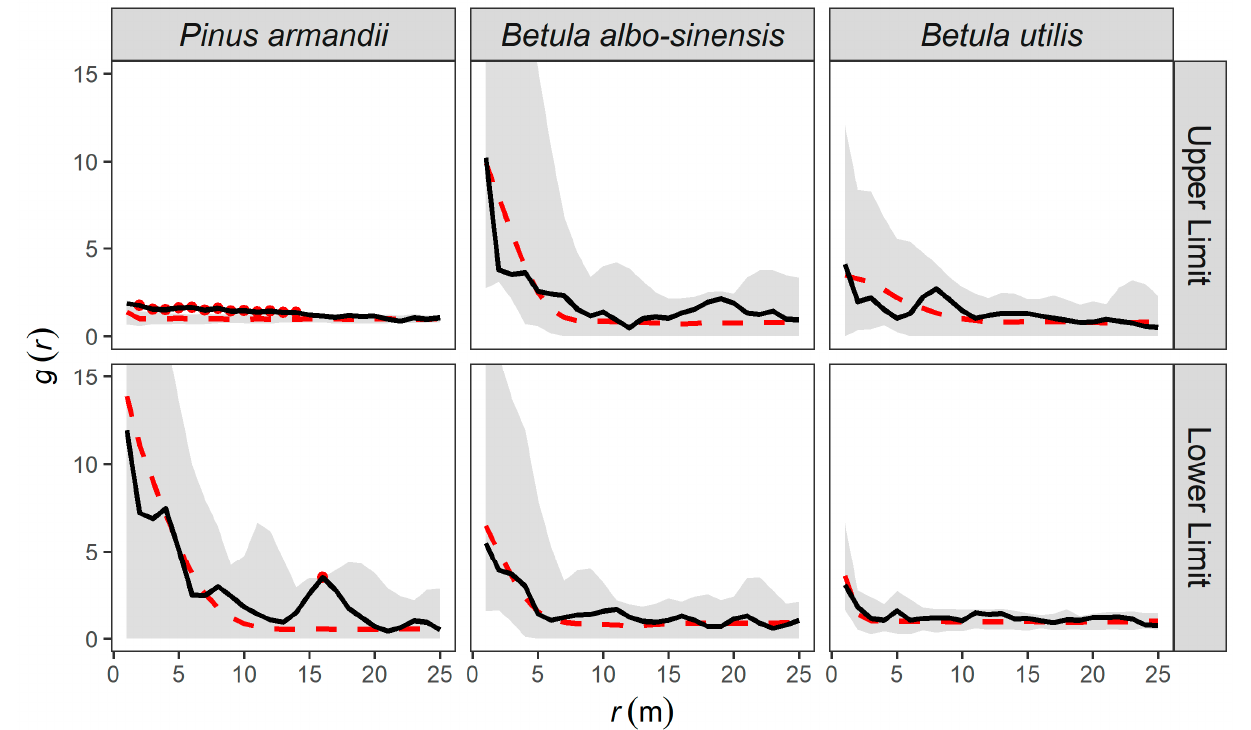
Figure 8. HT null model analysis of the spatial patterns of P . armandii , B . albo-sinensis , and B . utilis at the upper limit and lower limit of the treeline patch. Note: the red points are the g -values beyond the upper envelope at a corresponding scale, the blue points are the g -values under the lower envelope at a corresponding scale.